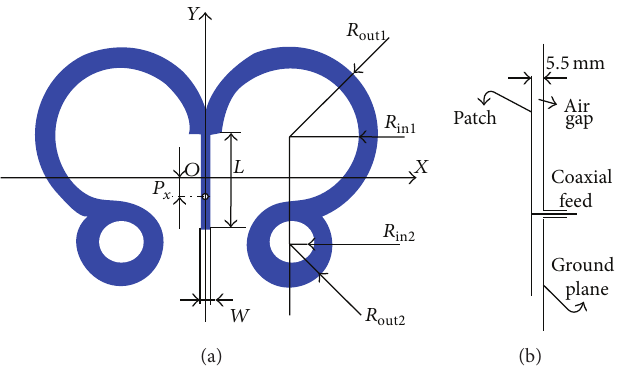
Figure 1: Schematic representation of the proposed butterfly-shaped patch antenna. (a) Top view, (b) lateral view.